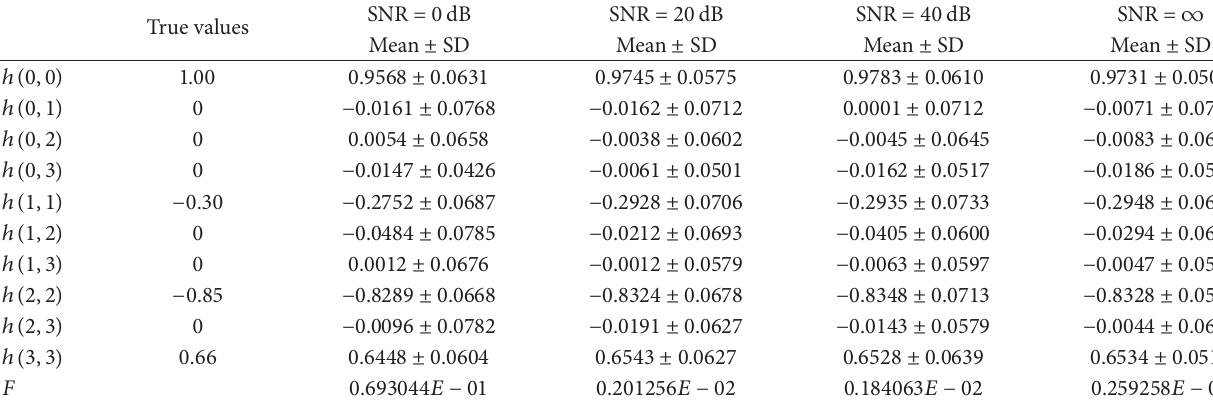
Table 2: Identified results [E1: full element ℎ(𝑖,𝑗)